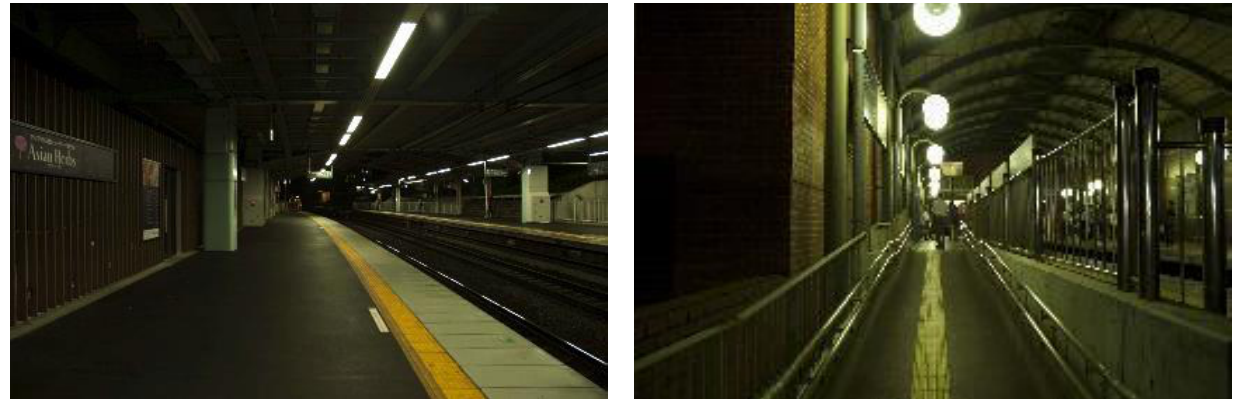
Figure 16. Results of the impression evaluation of ‘want to change the lighting’ and floor illuminance.